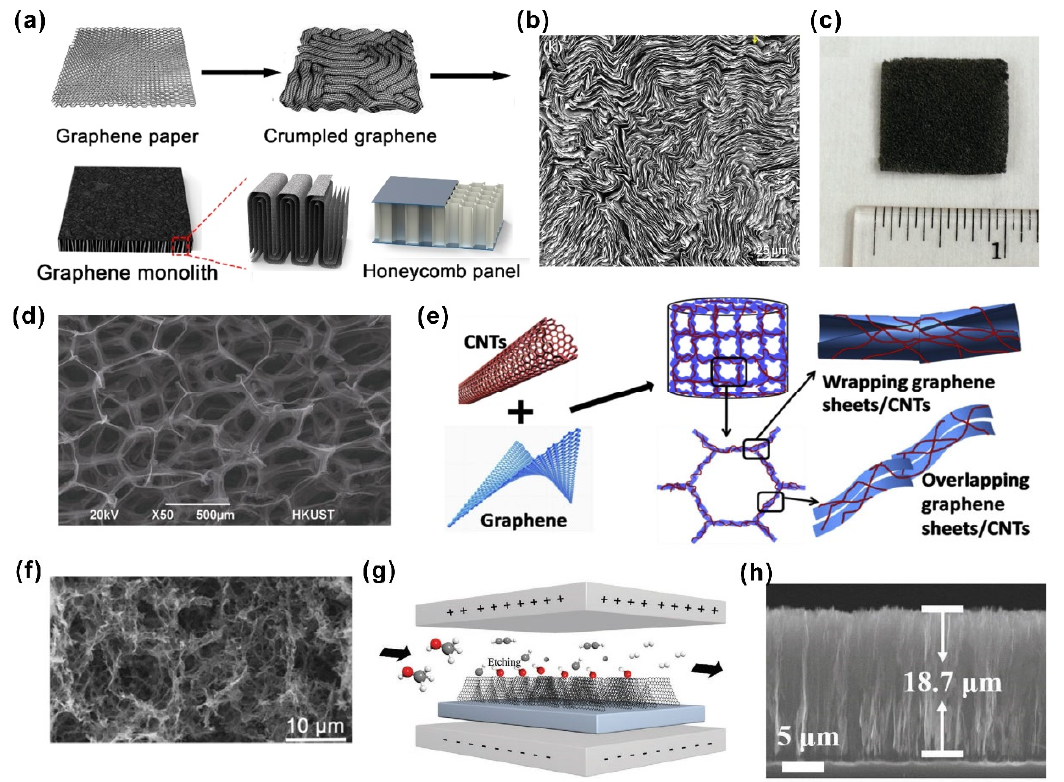
Figure 4. ( a ) The fabrication process for graphene monolith. ( b ) The top view SEM image of verti ‐ cally aligned graphene sheets (Figure 4a,b reprinted/adapted with permission from Ref. [81] . 2019, the American Chemical Society). ( c ) The picture of 3D graphene skeleton foam. ( d ) The SEM image that shows the 3D interconnected thermal pathways inside graphene foam (Figure 4c,d re ‐ printed/adapted with permission from Ref. [83]. 2014, Elsevier). ( e ) The method of super ‐ elastic gra ‐ phene–carbon nanotube aerogel. ( f ) The SEM image of as ‐ prepared graphene–carbon nanotube aer ‐ ogel (Figure 4e,f reprinted/adapted with permission from Ref. [79]. 2016, Elsevier). ( g ) The growth of vertical graphene arrays using electrical field. ( h ) The cross ‐ sectional SEM image of graphene arrays with a height of 18.7 μ m (Figure 4g,h reprinted/adapted with permission from Ref. [85]. 2020, Wiley).